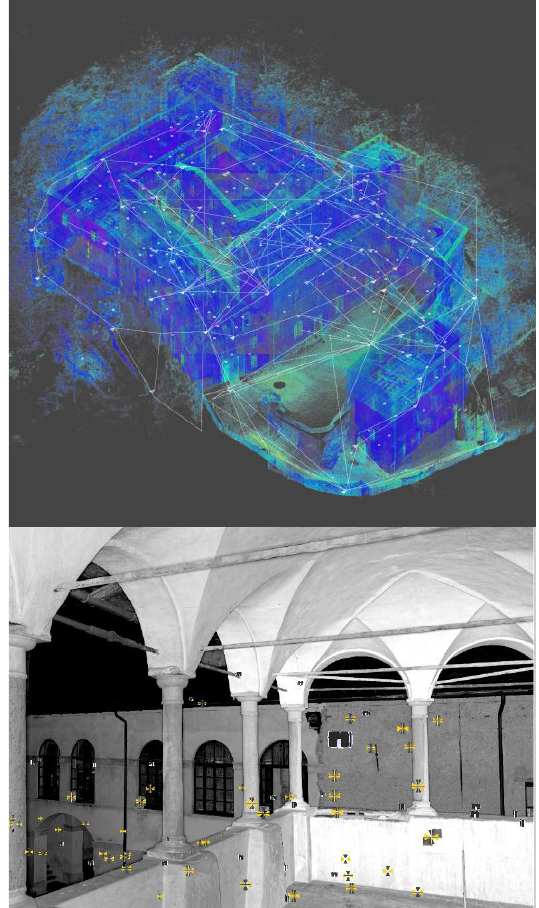
Fig. 3. Top: the geodetic network measured with a total station (the average precision is ±1.2 mm) and a 3D view of laser scans (7.5 billion points). Bottom: panoramic visualization of a single scan.